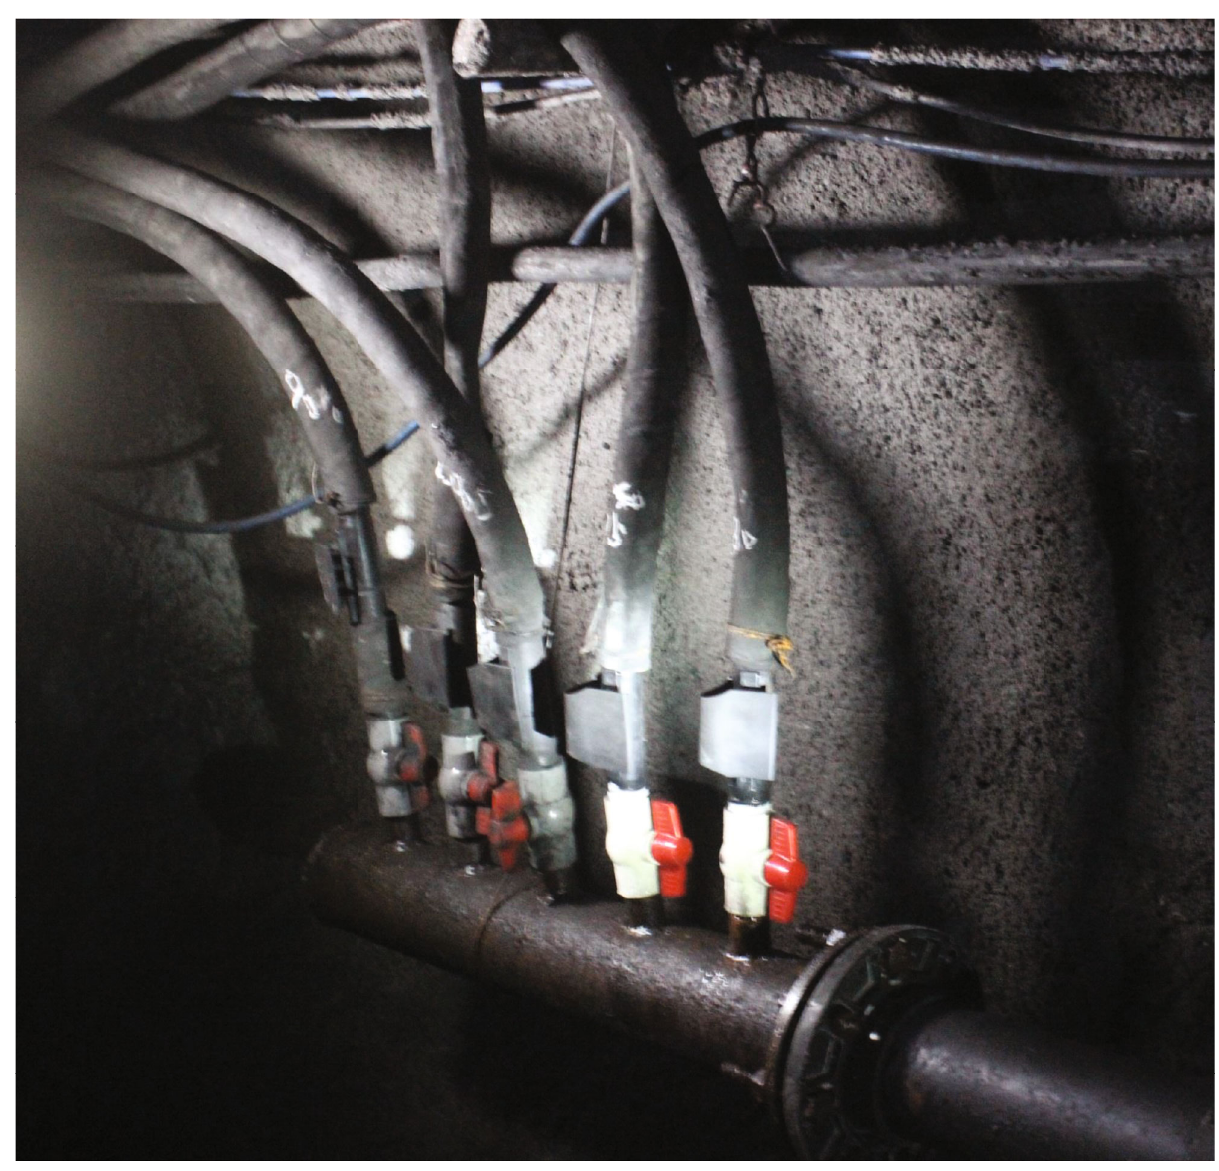
Figure 13: Borehole construction and borehole